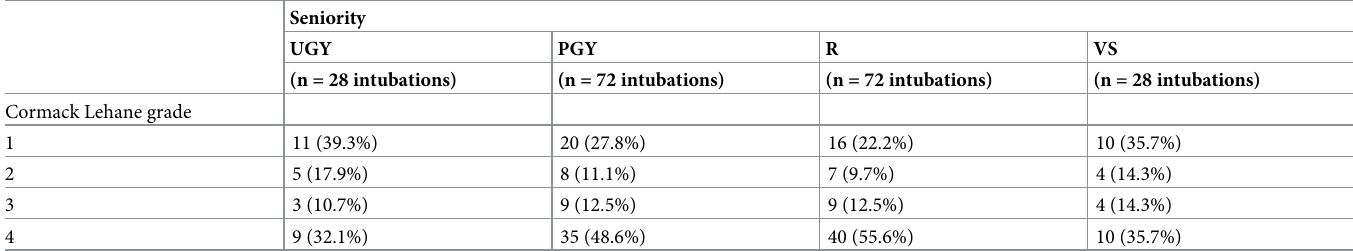
Fig 4. Mean peak force (N) applied on incisors across UGY, PGY, R and VS in different intubation scenarios. Error bars represent ± 1 SE. https://doi.org/10.1371/journal.pone.0257969.g004 Table 1. Cormack Lehane grade across seniority using direct laryngoscopy in various